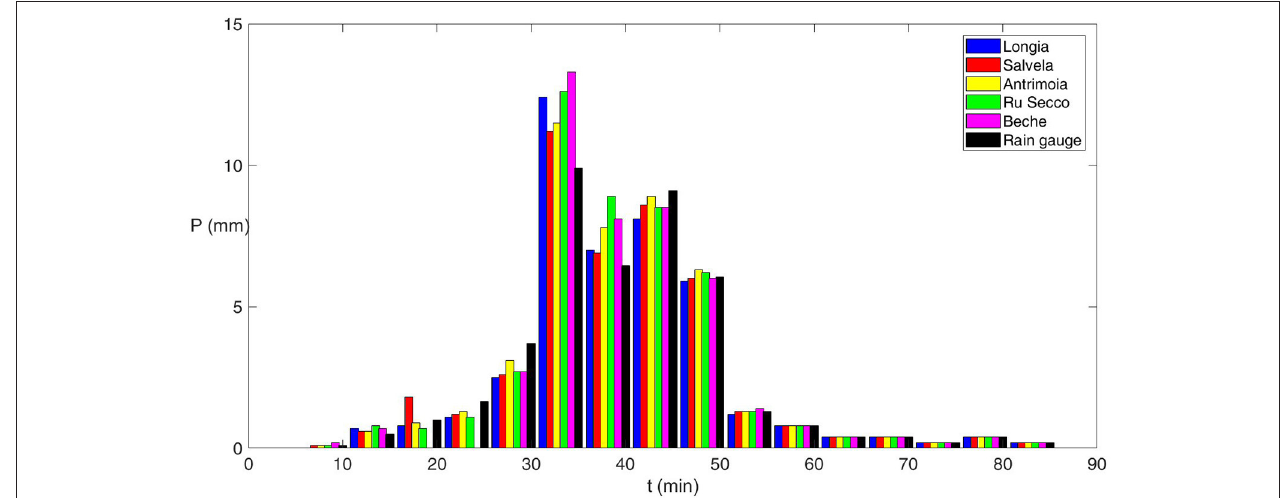
FIGURE 6 | Hyetograph of the rainfall depths from the rain gauge and the corrected radar